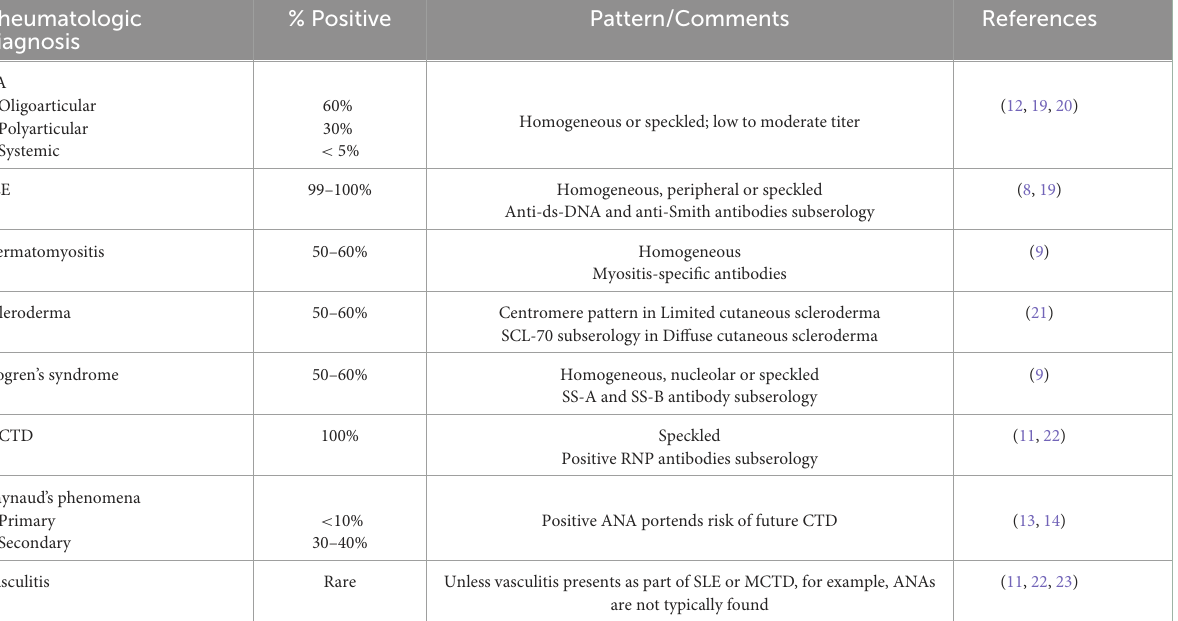
TABLE 2A Rheumatologic diagnoses with positive ANA.